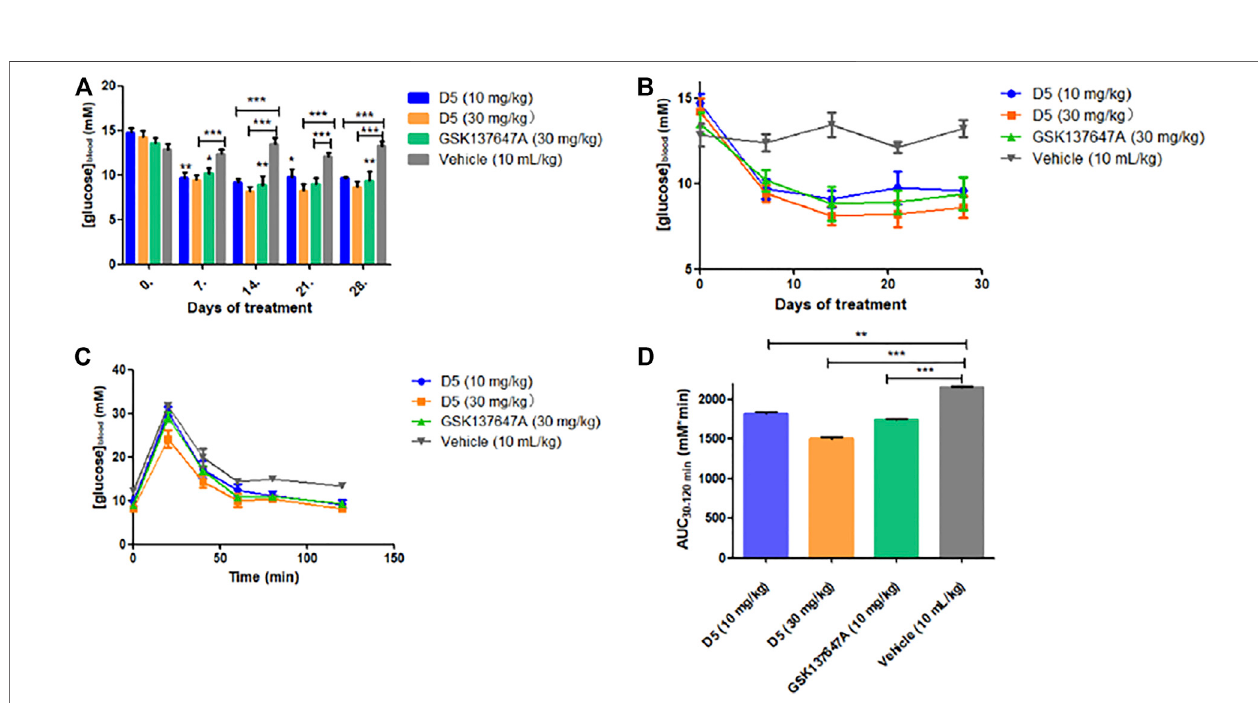
FIGURE 6 | (A, B) The fasting blood glucose values of db/db mice after 4 weeks of continuous administration. *** p ≤ 0.001; ** p ≤ 0.01; * p ≤ 0.05; (C, D) Blood glucose at a different time (5, 10, 30, 60, 120 min) after oral administration of glucose in mice.